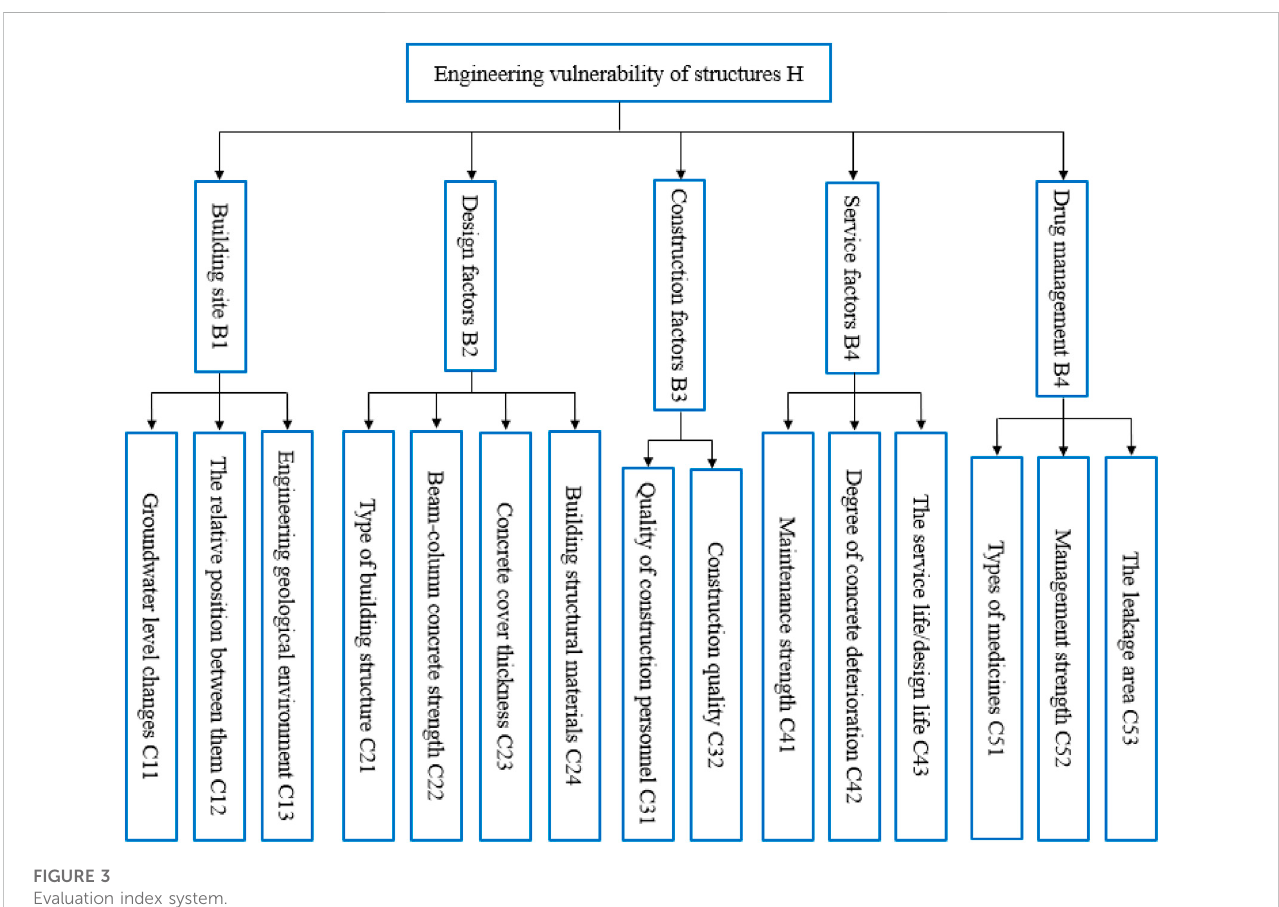
FIGURE 3 Evaluation index